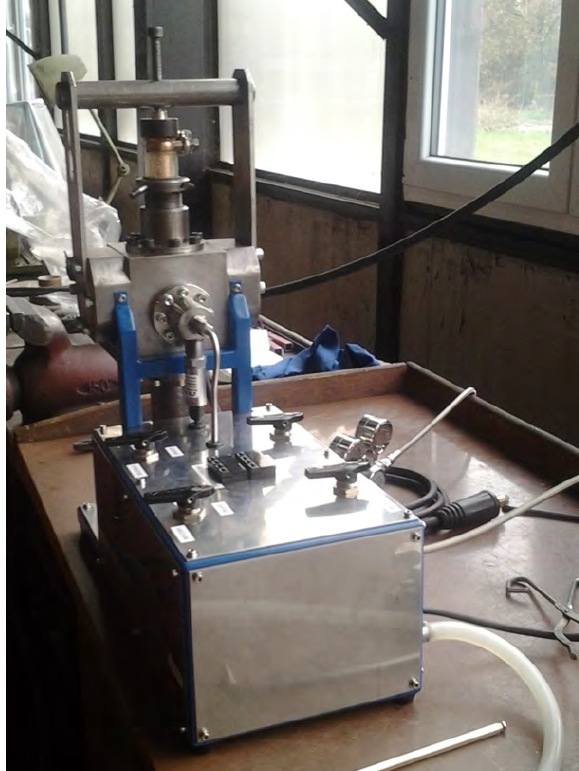
Figure 1. Device used for-welding samples.